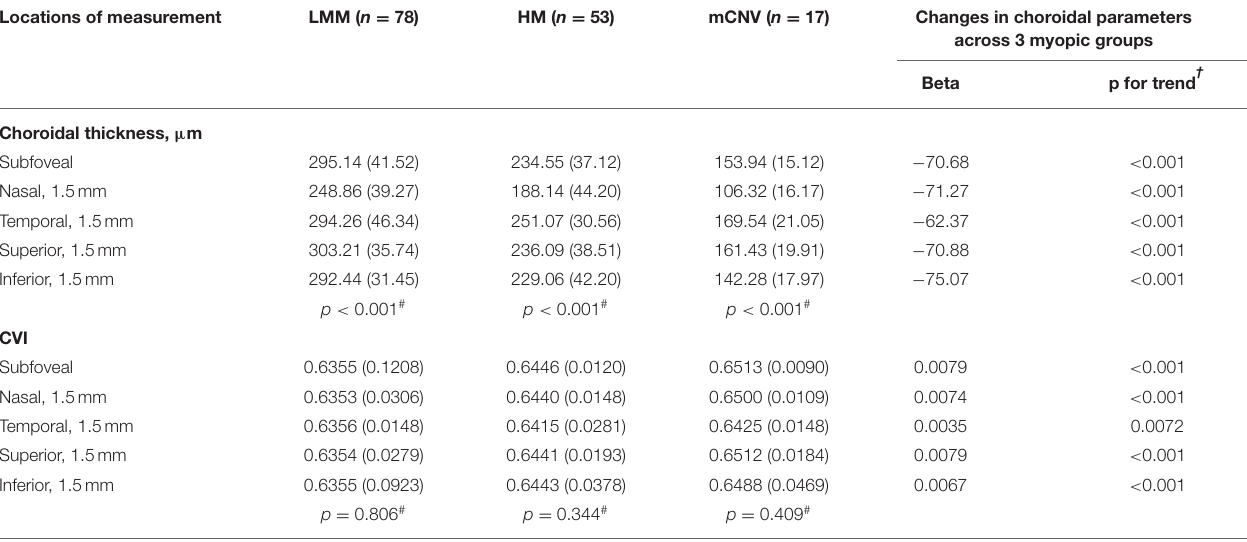
TABLE 4 | Distribution of CT and CVI at five different locations across the LMM, HM, and mCNV groups. Locations of